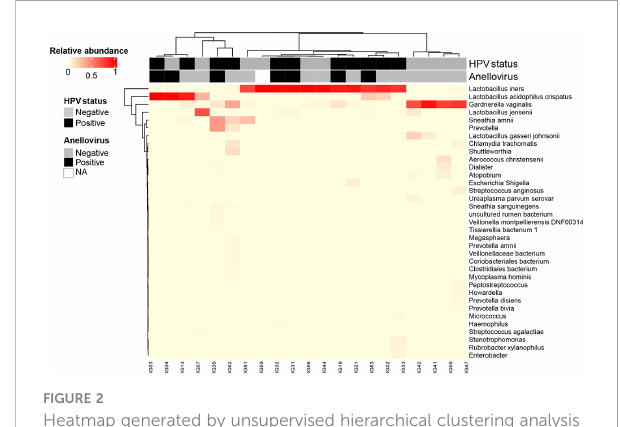
FIGURE 2 Heatmap generated by unsupervised hierarchical clustering analysis of cervical bacteriomes including HPV and Anellovirus status. CSTs were de fi ned using clustering based on Bray-Curtis dissimilarity and average linkage and then grouped based on vaginal health state in: healthy state – L. no-iners dominated (grouping CSTs I and V); transitional state – L. iners dominated (CST III); and dysbiosis state – No-Lacto dominated (CST IV). Relative bacterial abundance, HPV and Anellovirus statuses are color-coded according to the legend at the left of the Figure. All taxa shown in the graph presented relative abundance >1%. NA: not available. .